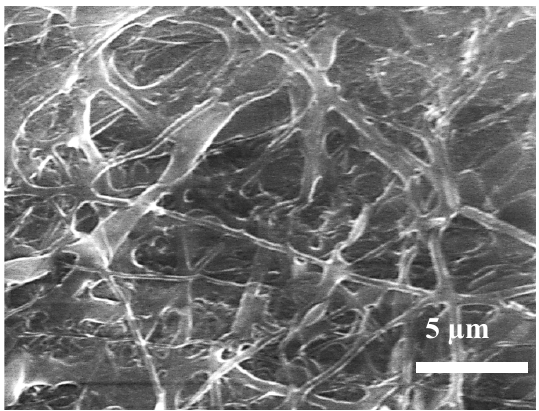
Figure 2. SEM images of ZnO/PVA as-spun